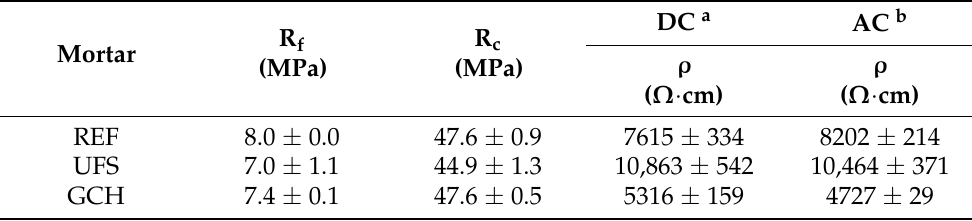
Table 3. Mechanical and electrical results of REF, UFS and GCH mortars after 28 days of curing.